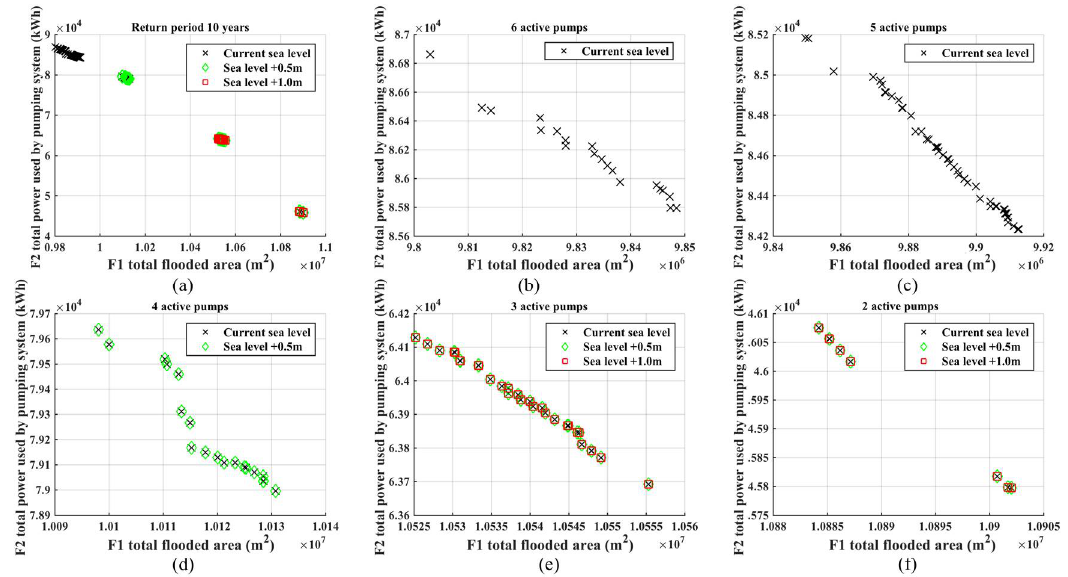
Figure 14. Pareto sets for a likely return period of 10 years. ( a ) Pareto set with all the pumping configurations. ( b ) Optimal Pareto set with a maximum of six pumps simultaneously working; and with ( c ) maximum of five pumps; ( d ) maximum of four pumps; ( e ) maximum of three pumps; and ( f ) maximum of two pumps.